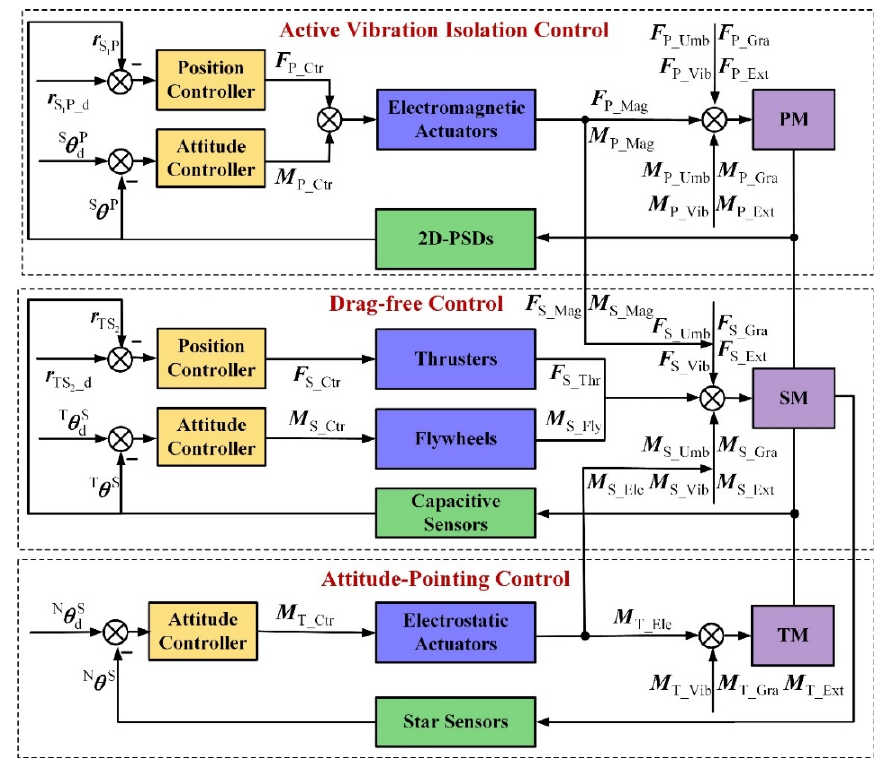
Figure 3. Control scheme of the improved DFP spacecraft.